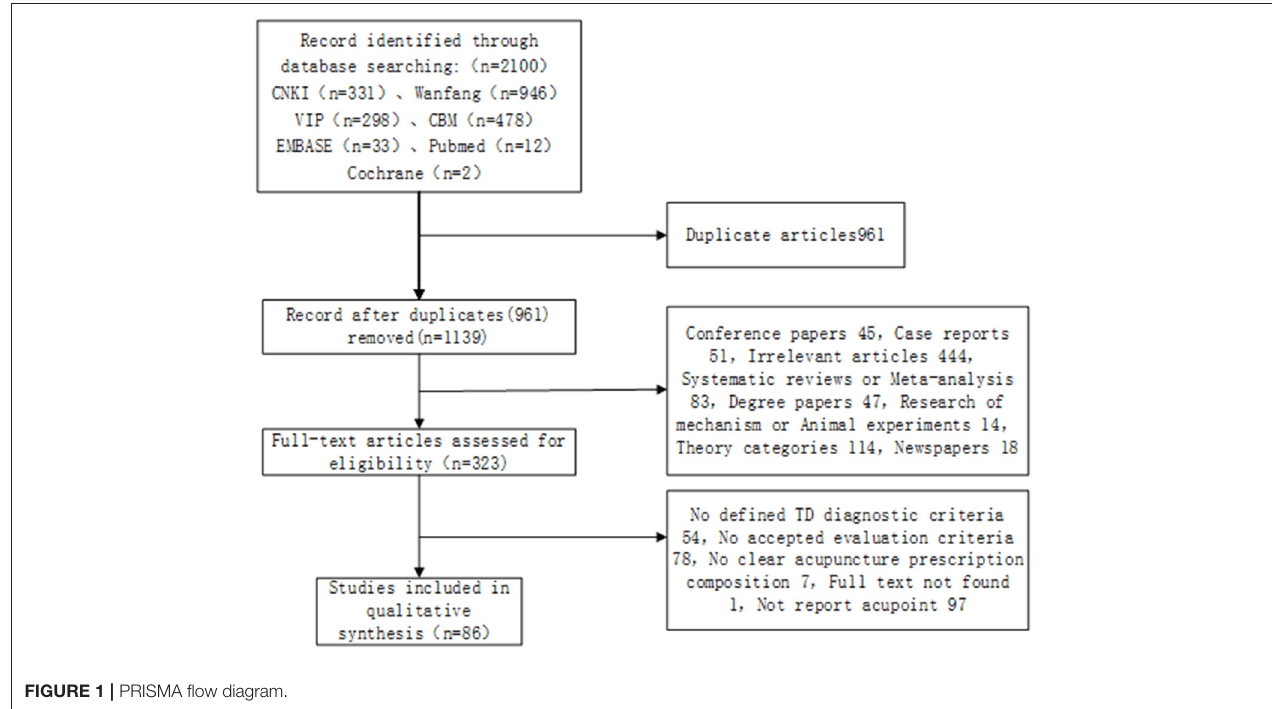
FIGURE 1 | PRISMA flow diagram.